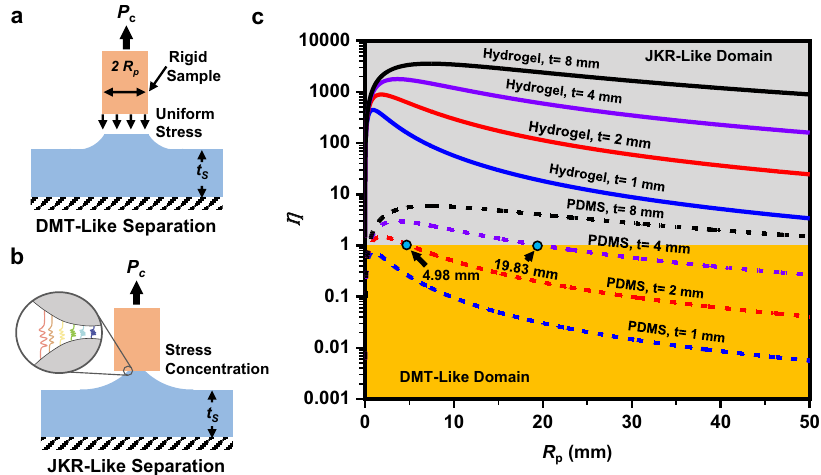
Fig. 3 Comparison of the separation mechanisms using PDMS and hydrogel interfacial layers. a Illustration of the DMT-like separation. b Illustration of the JKR-like separation. c JKR-DMT transition phase diagram of the separation process for PDMS and hydrogel interfaces. P c is the separation force, R P is the radius of the punch, t s is the elastic modulus of the